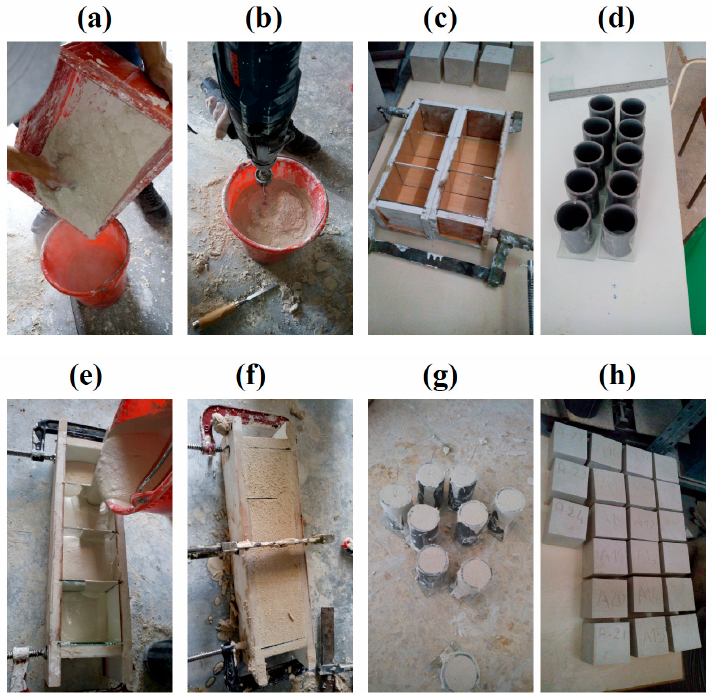
Figure 6. Steps of specimens’ preparation process :( a ) Add the gypsum plaster to water, ( b ) Mix in wet condition, ( c , d ) Molds preparation, ( e ) Molds casting, ( f , g ) Specimens drying, ( h ) Specimens demolding